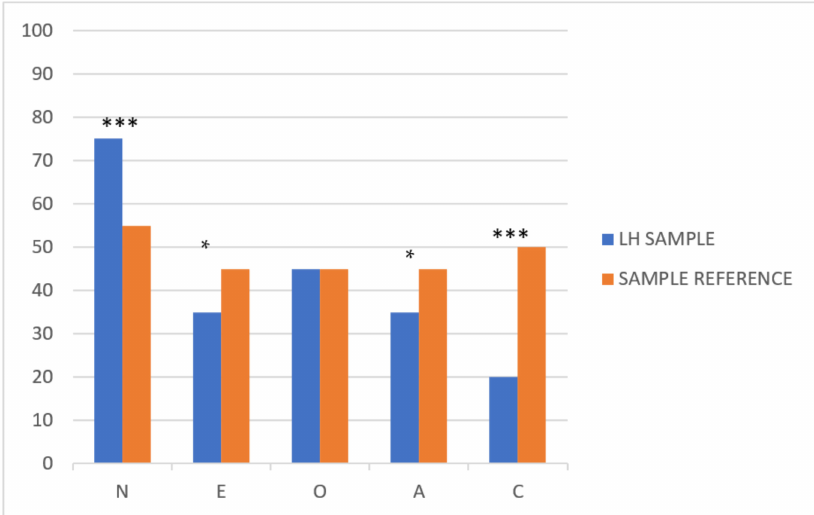
Figure 1. Profile of general personality traits in Hodgkin lymphoma (HL) and reference sample